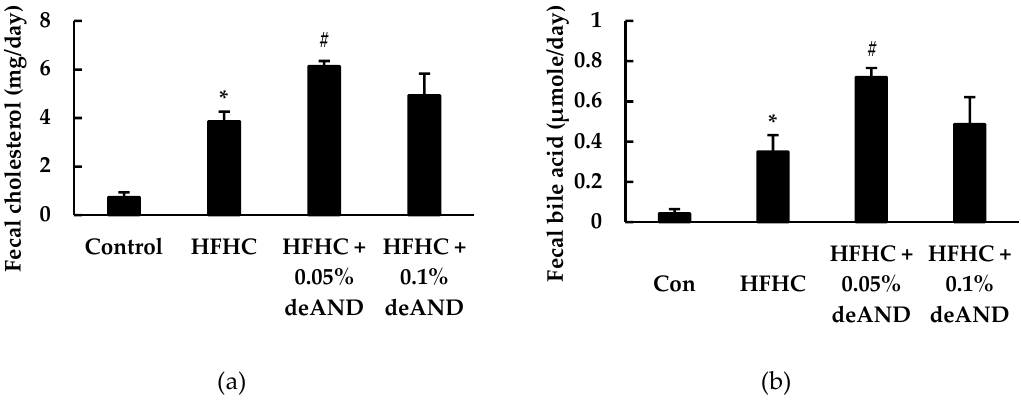
Figure 4. Effects of administrated of deAND on fecal cholesterol ( a ), and total bile acids ( b ) contents in rats. Results are expressed as the mean ± S.D. ( n = 3). * Significantly different from the control group at p < 0.05. # Significantly different from HFHC group, p < 0.05. The feces in each group (six mice in one cage) was collected for three consecutive days and then the fecal cholesterol and bile acids from pooled samples in each group were determined in triplicates.